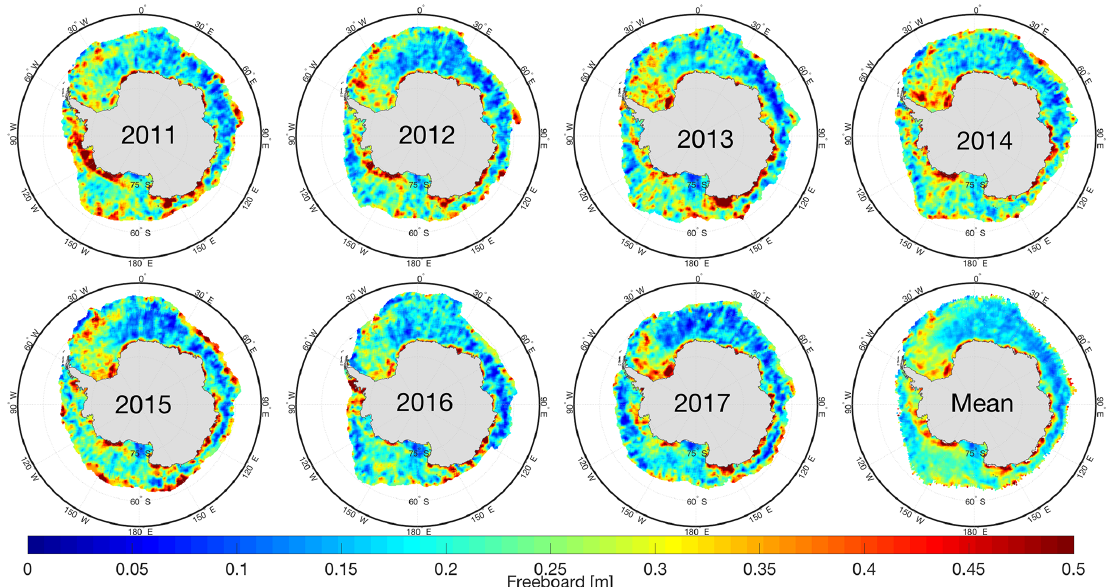
Figure 8. October monthly average snow freeboard from 2011 to 2017, as well as the mean of all years, found using this retrieval method.